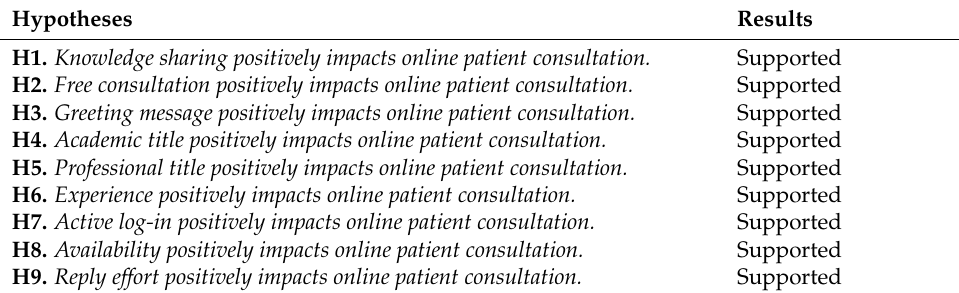
Table 4. Test of